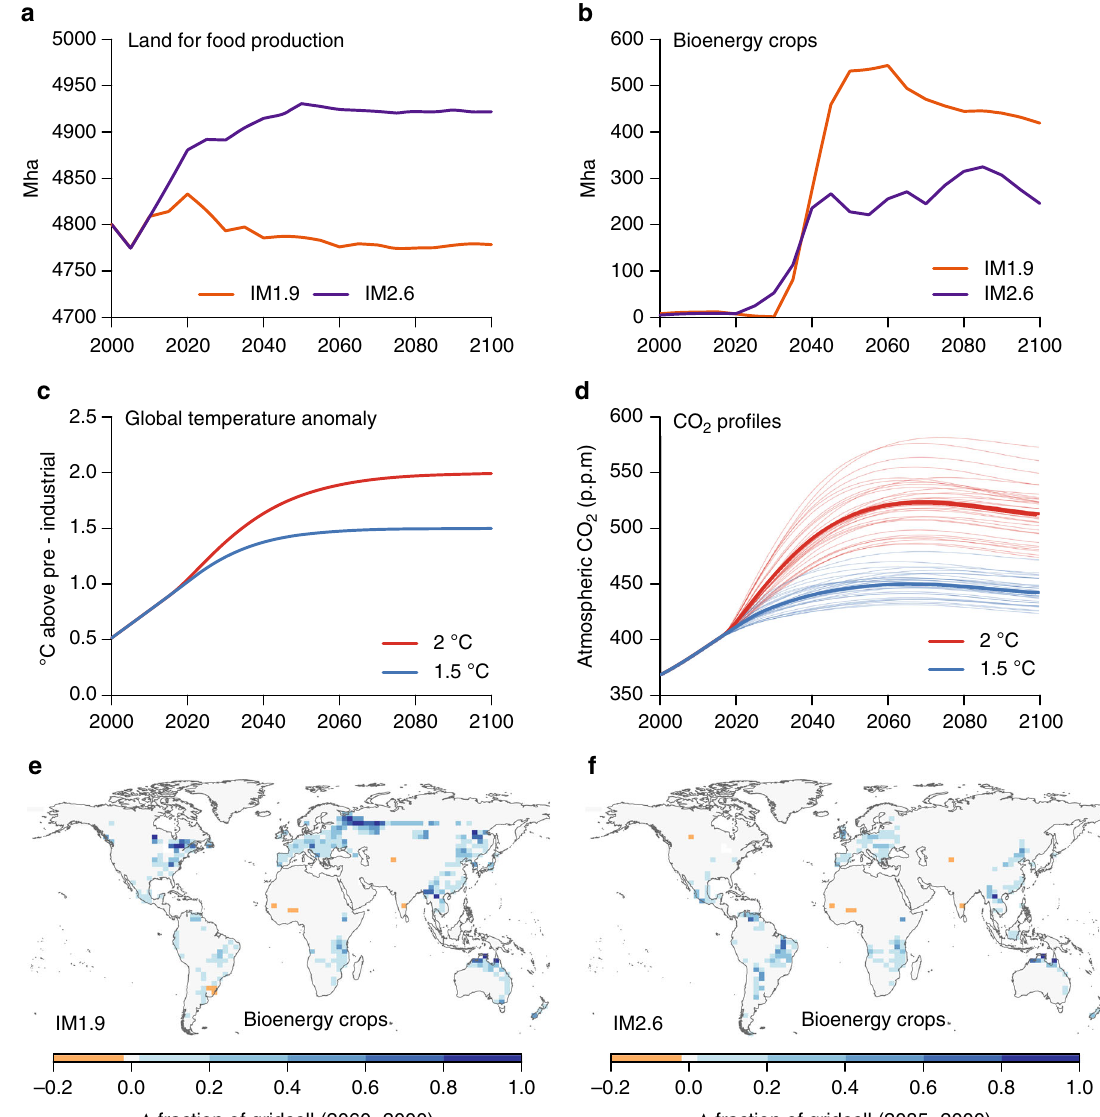
Fig. 1 Scenarios for land-use and climate change. a , b Land used for food production (crops and pasture) and bioenergy crops from the IMAGE SSP2 scenarios IM1.9 and IM2.6 (available from https://data.knmi.nl/datasets?q = PBL). c Temperature pro fi les for the idealized scenarios reaching nearly 1.5 °C and 2 °C by 2100. d CO 2 concentrations for each of the 34 ESMs emulated with IMOGEN. The CO 2 concentrations relate to the temperatures in c depending on each model ’ s climate sensitivity (Methods). e , f Spatial maps of change in land for bioenergy crops in IM1.9 and IM2.6. For each scenario, the change is shown as the difference between 2000 and the year of maximum extent of bioenergy crops (2060 for IM1.9 and 2085 for IM2.6)